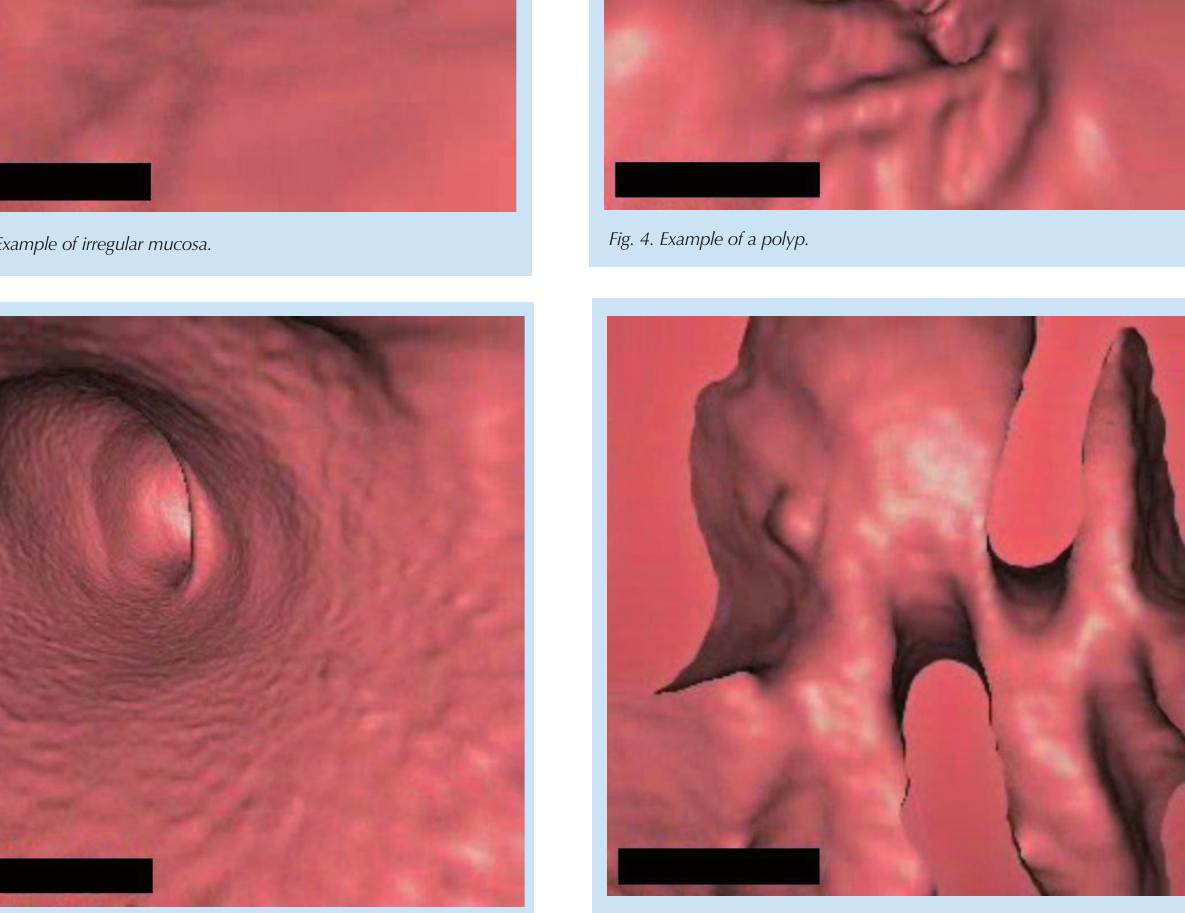
Fig. 5. Example of a small